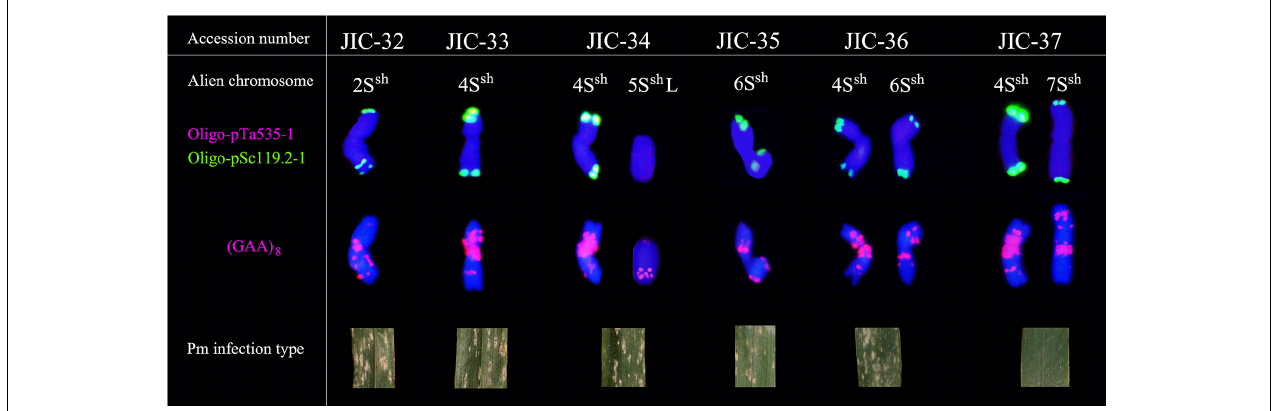
FIGURE 3 | Standard FISH pattern of A . sharonensis chromosomes using Oligo-nucleotides as probes. Row one indicates alien chromosome; Row two indicates double-color FISH patterns using Oligo-pTa535-1 (red) and Oligo-pSc119.2-1 (green) as probes; Row three indicates FISH patterns using (GAA) 8 (red) as probes after washing off the double-color FISH signals; Row four indicates photos of powdery mildew in wheat- A. sharonensis chromosome lines. TABLE 1 | PLUG primer pairs screened to identify specific markers of Aegilops sharonensis chromosomes. Chromosome Number of PLUG primer Number of polymorphic markers homoeologous groups pairs which could be located on A. sharonensis